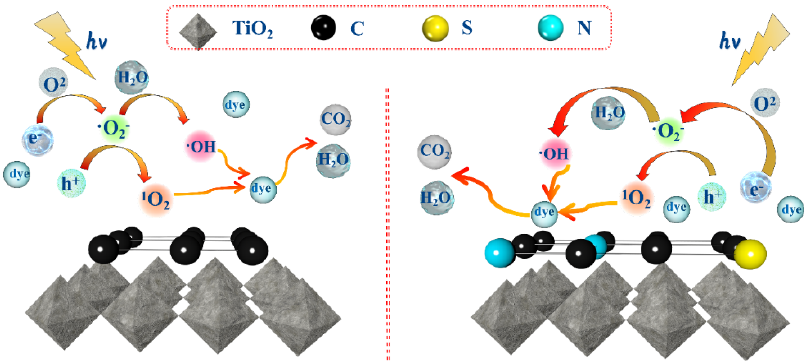
Figure 13. The proposed photocatalytic reaction mechanism for the photodegradation of MB dyes by both the calcined TiO 2 film and calcined keratin char-TiO 2 composite film.